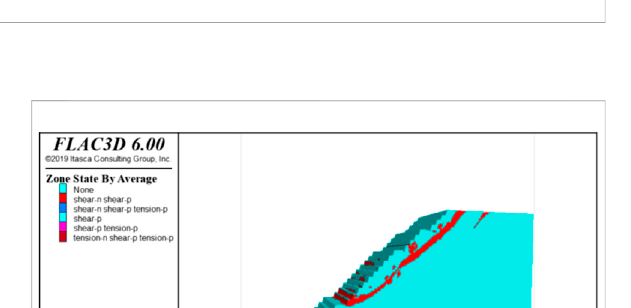
FIGURE 14 Velocity clouds in x and z directions after discounting slope strength.